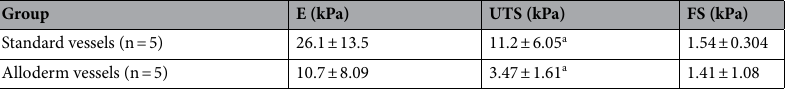
Table 3. Longitudinal vessel material properties. a Statistically significant difference between Standard Vessels and Alloderm Vessels (E: no significance; UTS: p < 0.05; FS: not